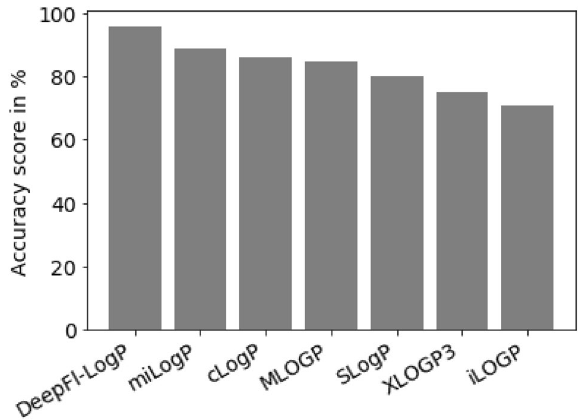
Figure 4. Ranking of LogP descriptors. The LogP descriptors are arranged in descending order according to accuracy score.